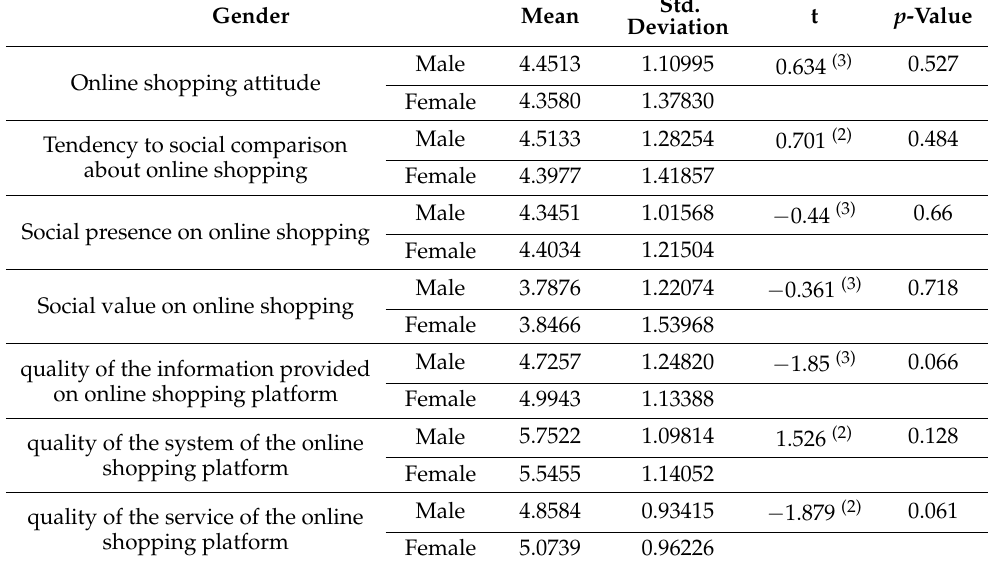
Table 7. T -test results and means for model variables according to